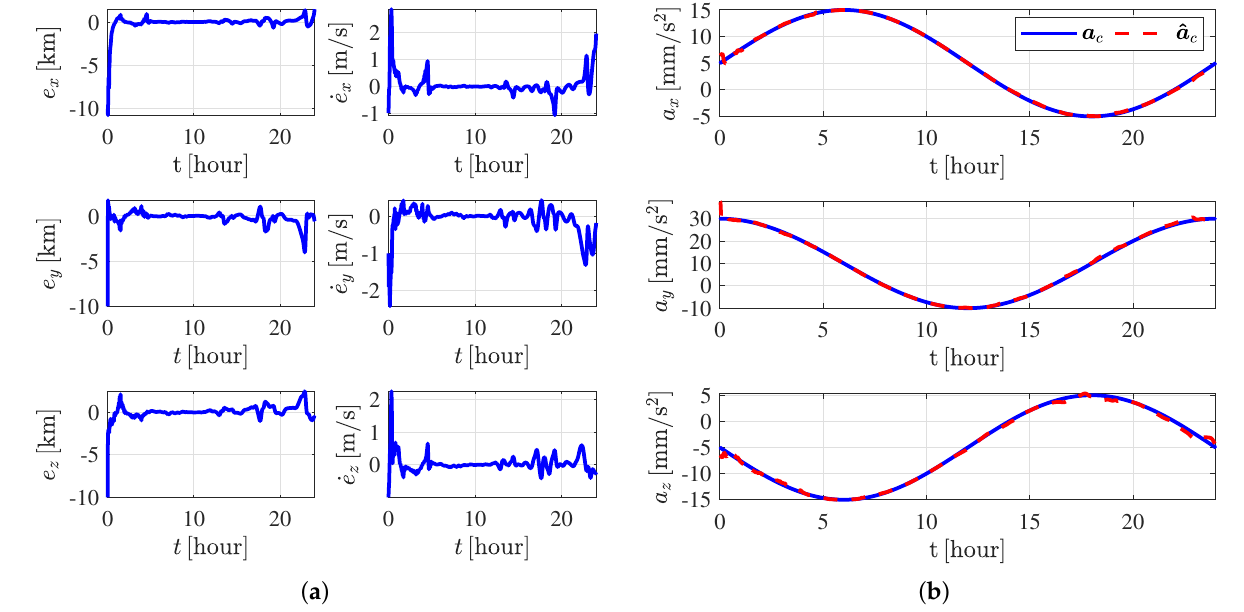
Figure 9. OD results using the sixth-order polynomials. ( a ) State estimated errors. ( b ) Maneuver estimated comparison (the blue lines denote the real maneuvering acceleration and the red dashed lines represent the estimated maneuvering acceleration).